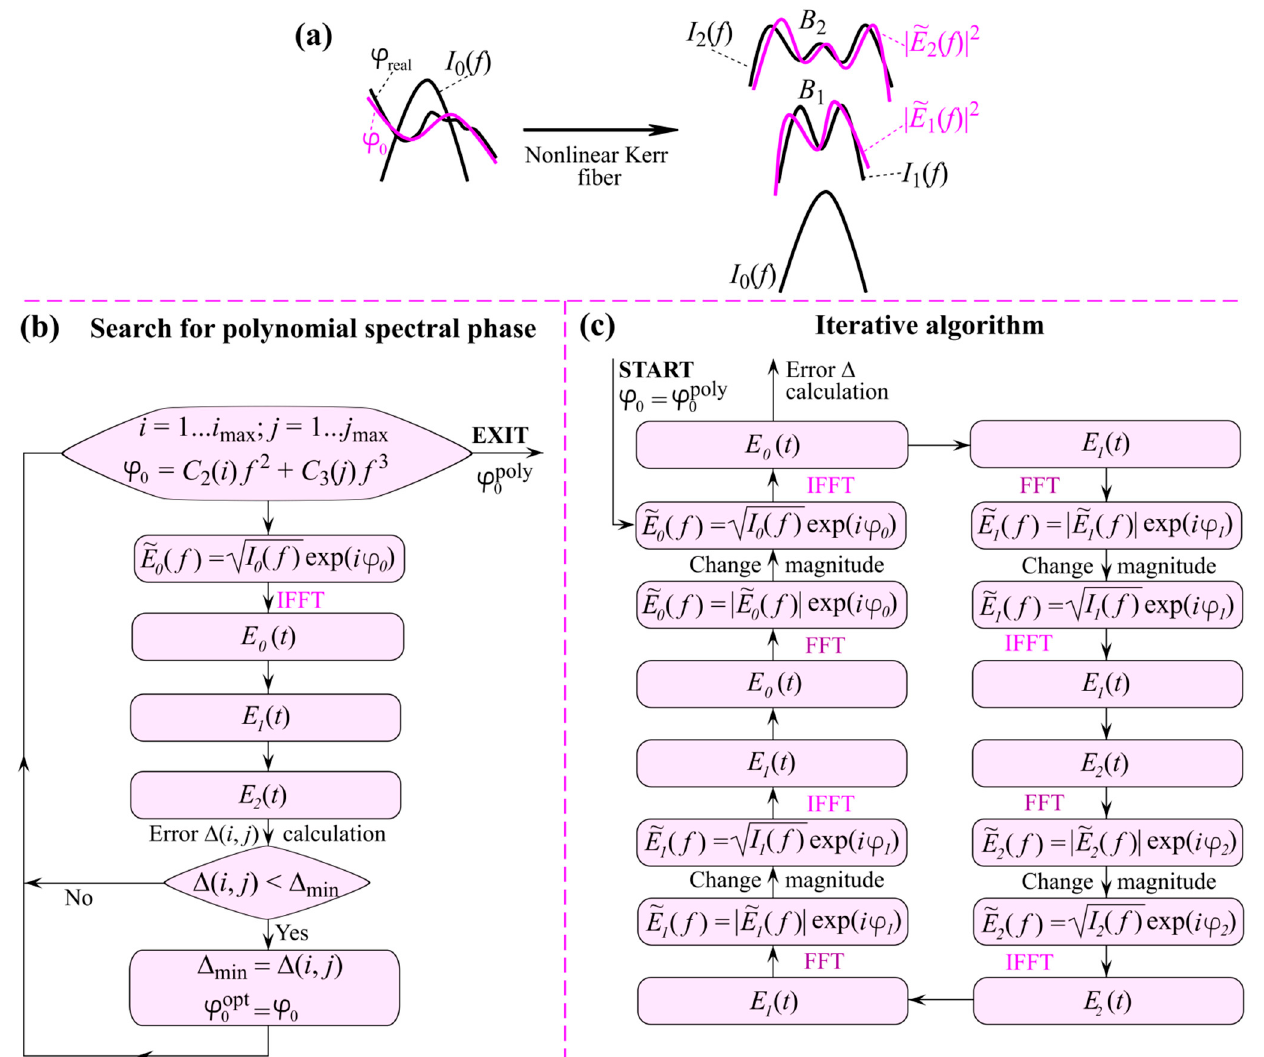
Figure 1. ( a ) Illustration of the method for pulse reconstruction based on processing of spectra converted in fibers with Kerr nonlinearity. ( b ) Block diagram of proposed algorithm of searching for optimal polynomial spectral phase (for certain B -integrals). ( c ) Block diagram of iterative algorithm (for certain B -integrals). Here, FFT is fast Fourier transform; IFFT is inverse FFT.